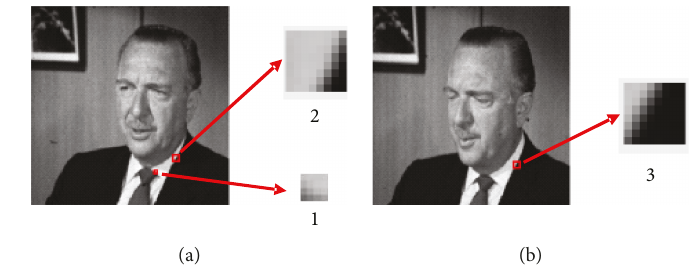
Figure 4: Combinatorial